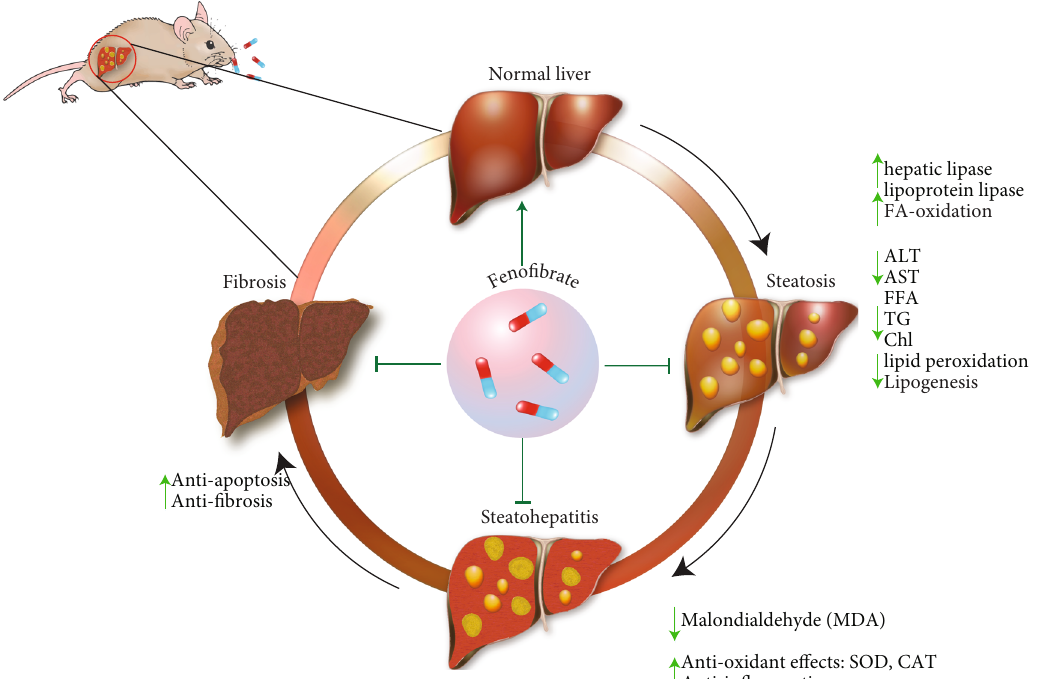
Figure 1: The e ff ects of feno fi brate on NAFLD, which involves several di ff erent mechanisms to reduce hepatic lipid accumulation and increase antioxidant, anti-in fl ammatory, and anti fi brotic